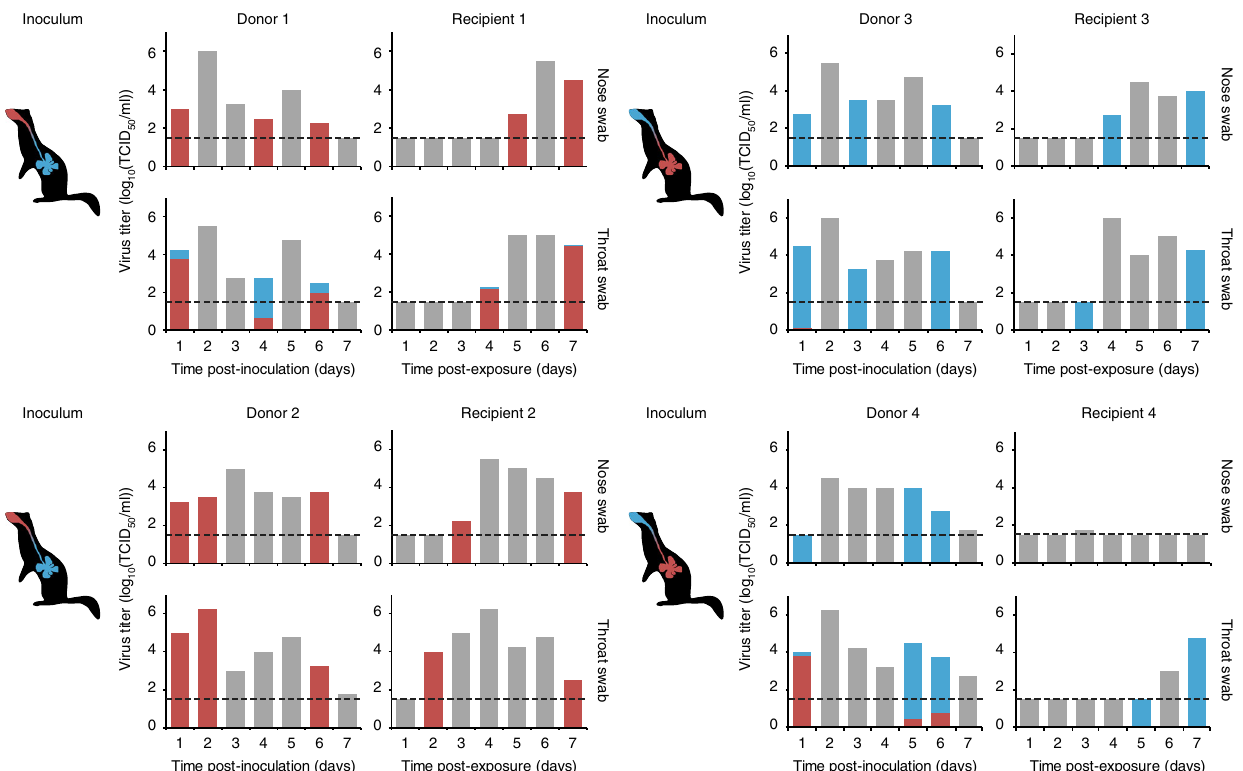
Fig. 1 The A/H1N1 virus was transmitted from the upper respiratory tract of ferrets. Donor ferrets 1 and 2 were inoculated intranasally with 10 5 TCID 50 of the A/H1N1 virus (shown in red) and intratracheally with 10 5 TCID 50 of the A/H1N1 var virus (shown in blue). Donor ferrets 3 and 4 were inoculated with the opposite placement of viruses. Recipient ferrets were added to the adjacent cage at 4 hpi. Virus titers in the nose and throat swabs were determined by TCID 50 assay and are indicated on the y-axis. The limit of detection of the virus titration is shown by the dotted line. The proportions of untagged (red) and tagged (blue) viruses, as determined by next-generation sequencing on the PB2 gene, are indicated by the colored bars. The gray bars correspond to samples that were not included in the next-generation sequencing. Source data are provided as a Source Data fi